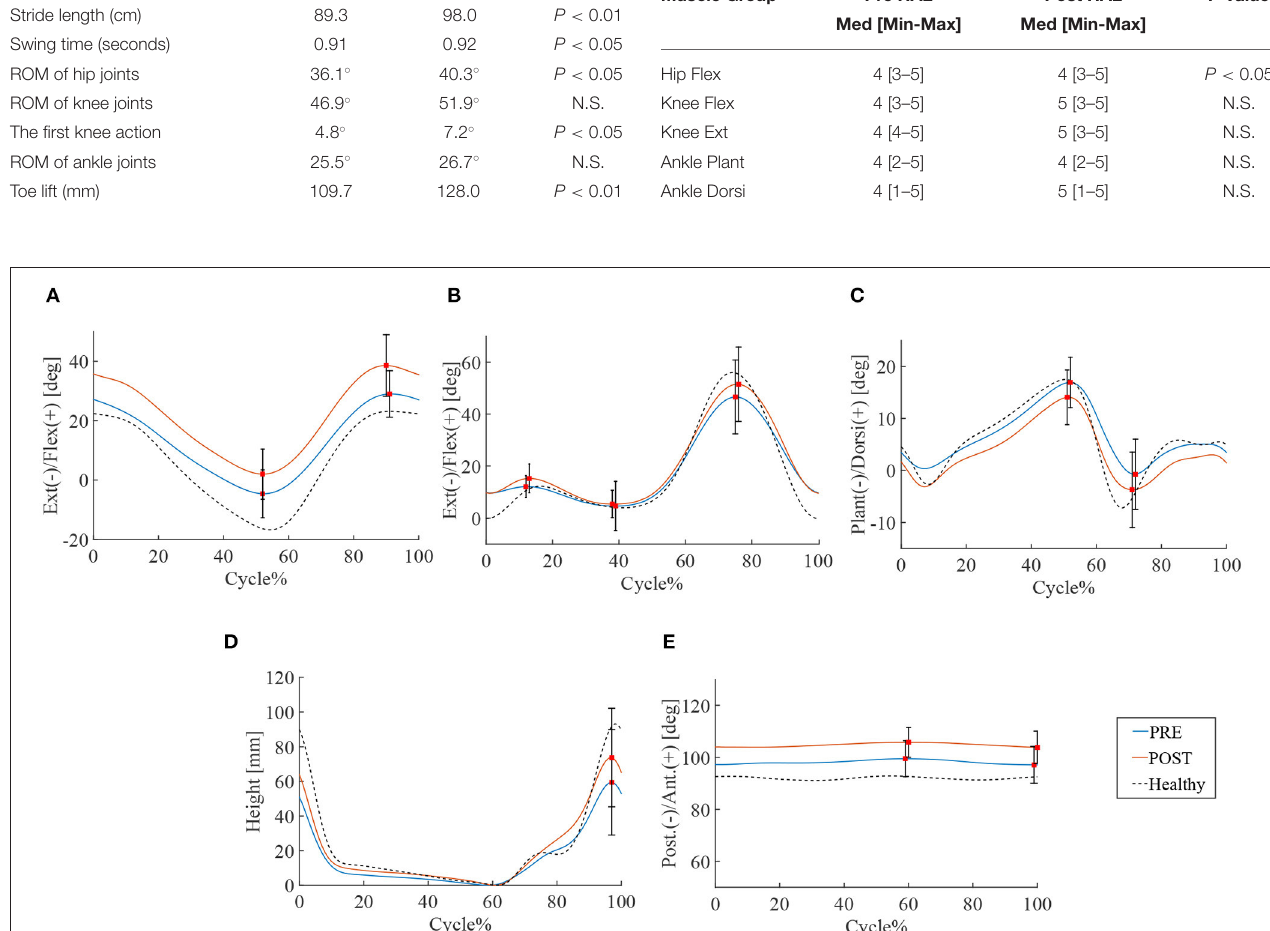
FIGURE 2 | Gait kinematics of chronic stage patients. Blue line is the mean of patients’ joint angle before HAL intervention, the red line is post HAL intervention, and the dotted line is gait analysis plot for percentage of walking cycle represents the normalized time. (A) Hip joint. (B) Knee joint. (C) Ankle joint. (D) Toe lift. (E) Pelvis.